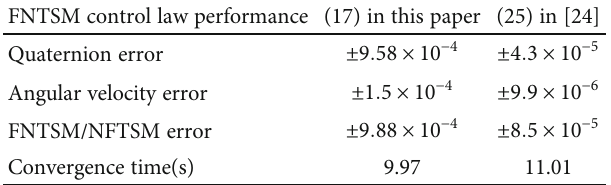
Table 2: The results on comparison of di ff erent controllers. FNTSM control law performance (17) in this paper (25) in [24] Quaternion